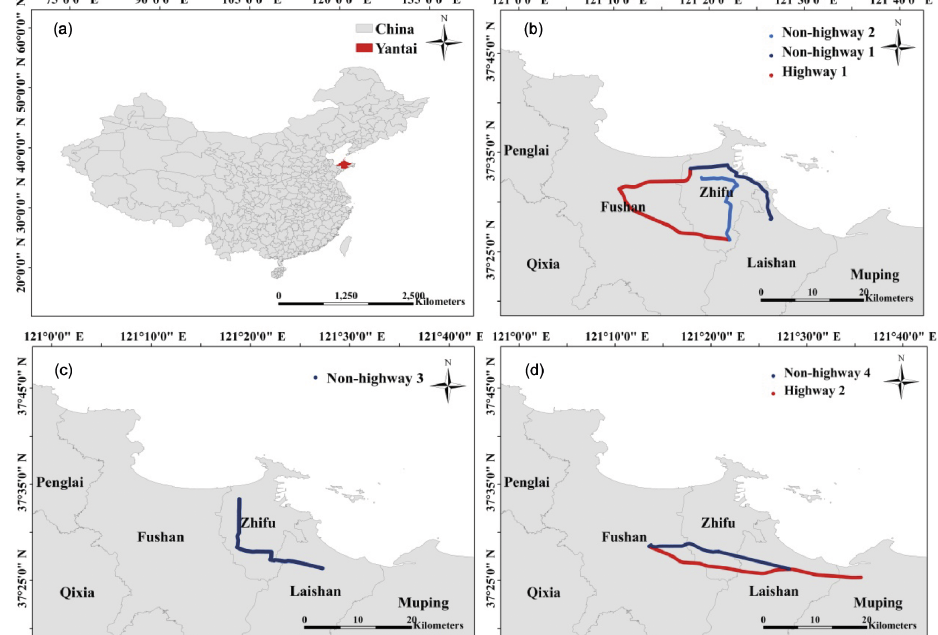
Figure 1. The routes for diesel trucks: (a) site of Yantai; (b) route for China III and China IV light-duty diesel trucks; (c) route for China II heavy-duty diesel truck; (d) route for China III medium-duty and heavy-duty trucks.